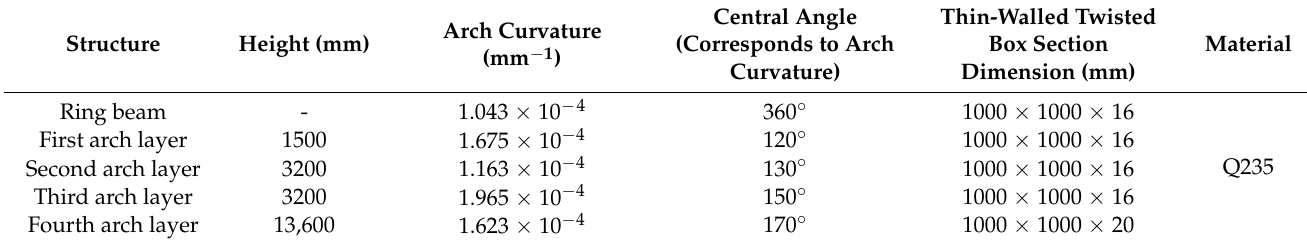
Table 1. Geometrical and material details of each arch layer.